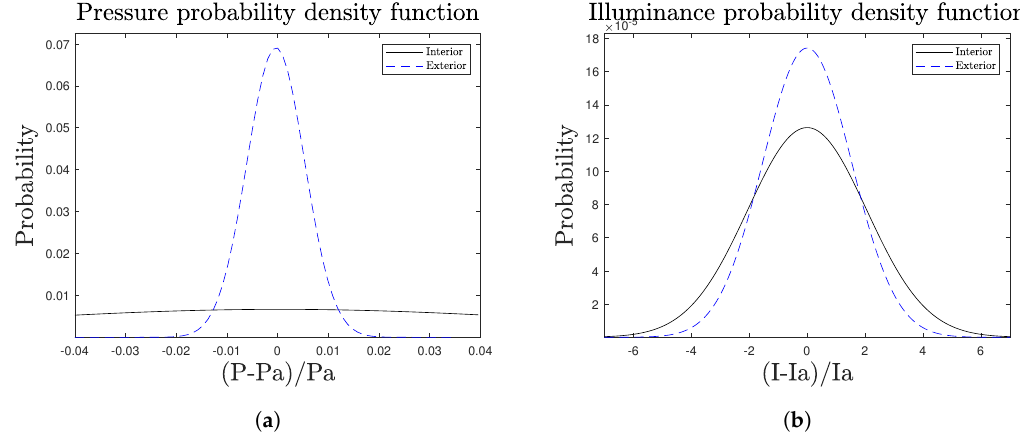
Figure 17. Comparative graphs of pressure and illuminance PDFs of the COMFORT (Interior) and METEO (Exterior) nodes, obtained for the month of December. ( a ) Atmospheric pressure PDF, ( b ) Illuminance